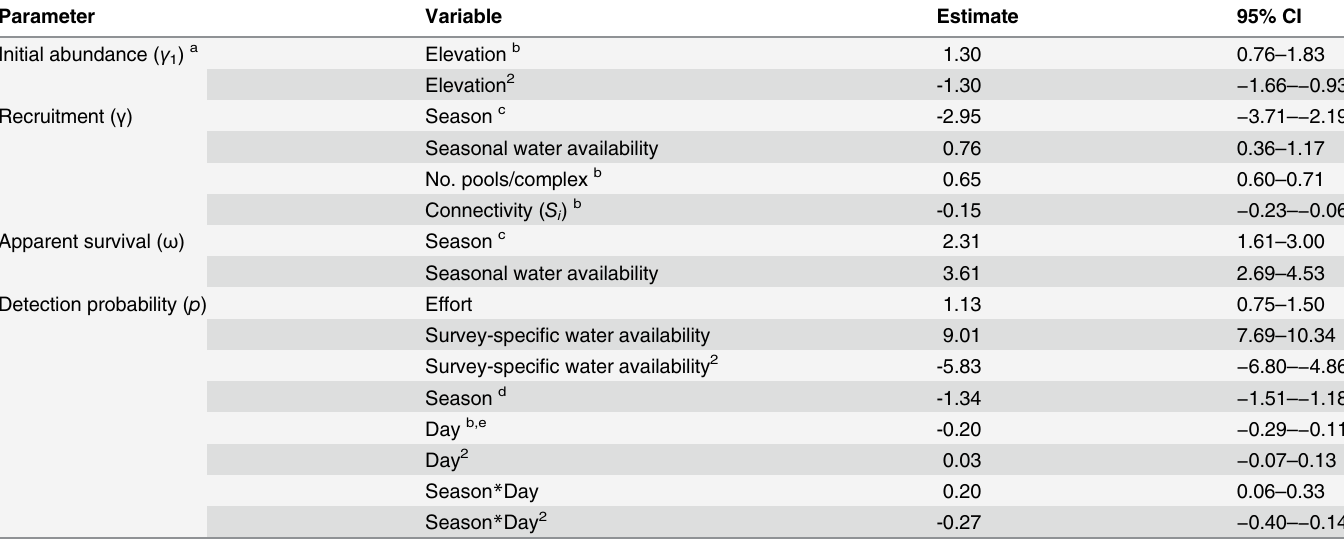
Table 2. Parameter estimates and 95% confidence intervals from a model describing abundance of adult leopard frogs in the Rincon Mountains, Arizona, USA between 1996 and